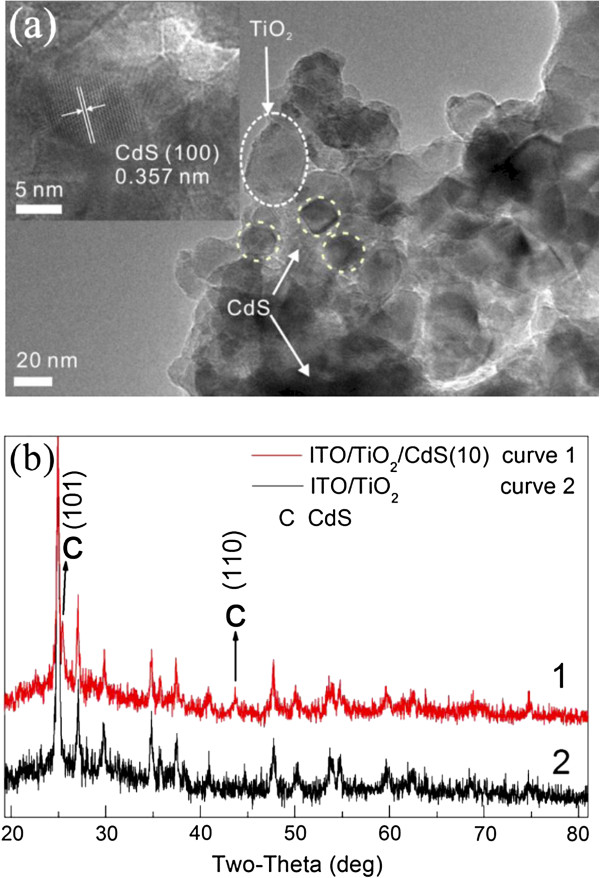
TEM images and XRD patterns of the films. (a) TEM images of the ITO/nc-TiO2/CdS(5) film at low and high (inset) magnifications. (b) XRD patterns of the as-prepared ITO/nc-TiO2 and ITO/nc-TiO2/CdS(10) films. C represents CdS. The large particles are titania Degussa P25 nanoparticles. The small dark spots belong to CdS nanoparticles with diameters of about 10 to15 nm.